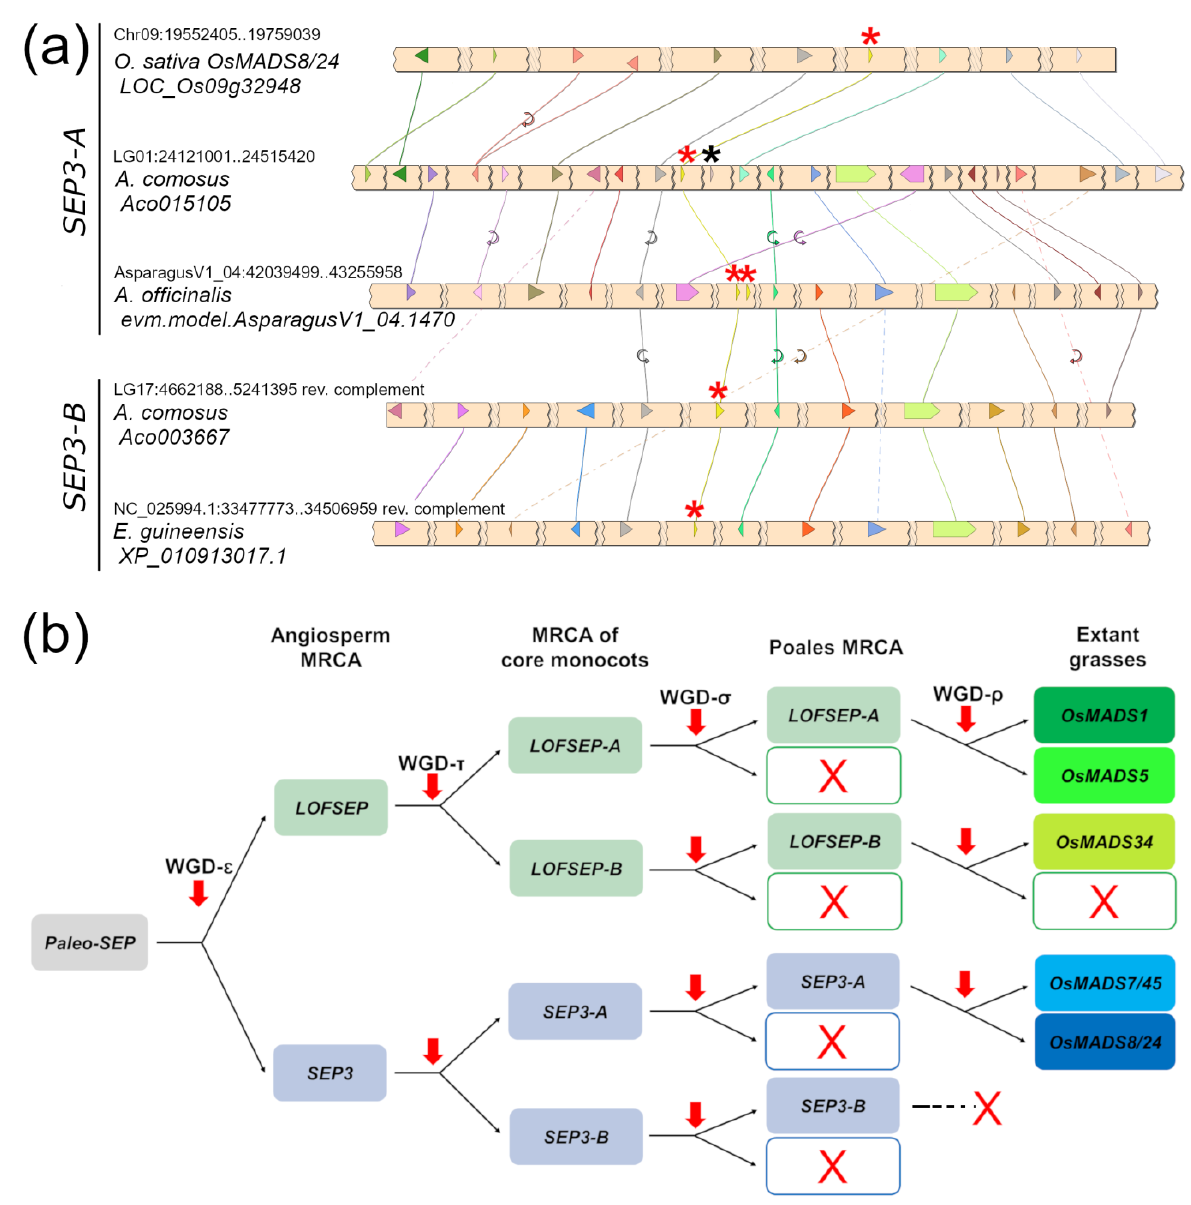
Figure 3. Evolutionary analysis of the SEPALLATA ( SEP ) subfamily in core monocots. ( a ) Microsyn- teny analysis of SEP3 genes from representative species of commelinids and Asparagales. Conserved loci are connected by lines of the same color. For simplicity, the non-conserved loci were omitted. In each chromosomal region, the SEP3 locus is marked with a red asterisk. The linked FLC locus, when present, is marked with a black asterisk. ( b ) Representation of the most likely pattern that drove the evolution of the SEP subfamily in extant grasses (Poaceae), based on our analysis and previous works. Based on the phylogeny results shown in Figure 1, the grass lineage lost SEP3-B after its divergence from the sister family